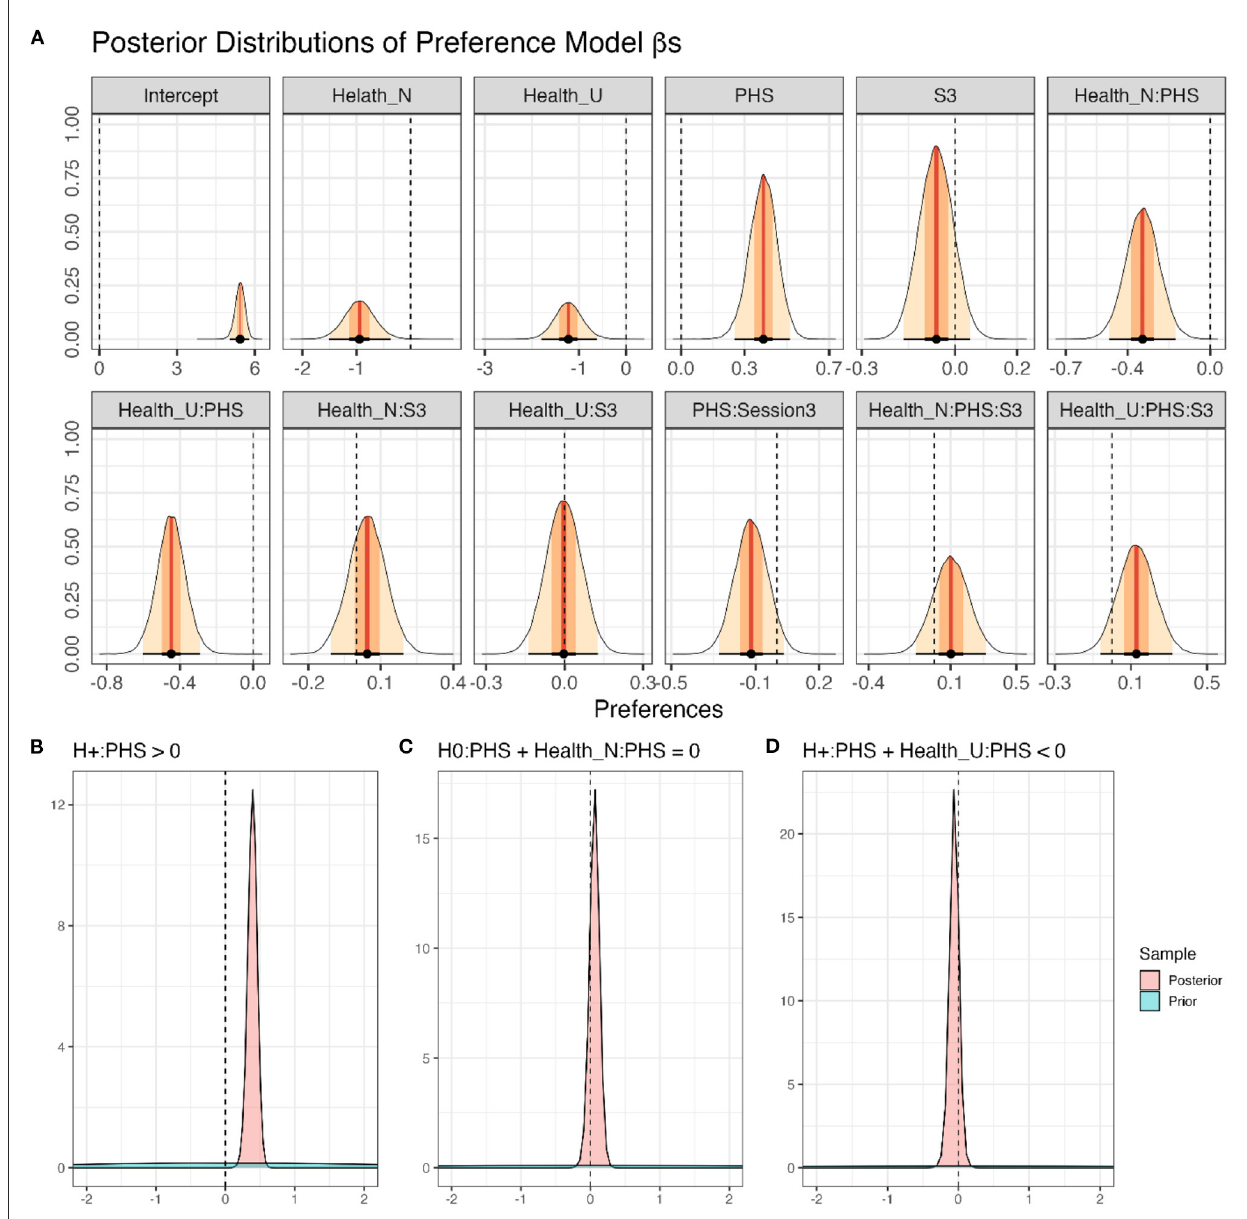
FIGURE3 Modeling of food preferences. (A) Density plots of posterior distributions of all β -coefficients included in the full Preference Model (Model 1; Equation 1). The presented values are back-transformed from the cumulative logit scale. Red lines and orange and yellow shadows represent the mean point estimates and the 50 and 95% highest probability density (HPD) areas, respectively. Please note the different scalings of the X-axes. (B–D) The posterior distributions for specific a priori hypotheses. For more details regarding the hypotheses and results, see the